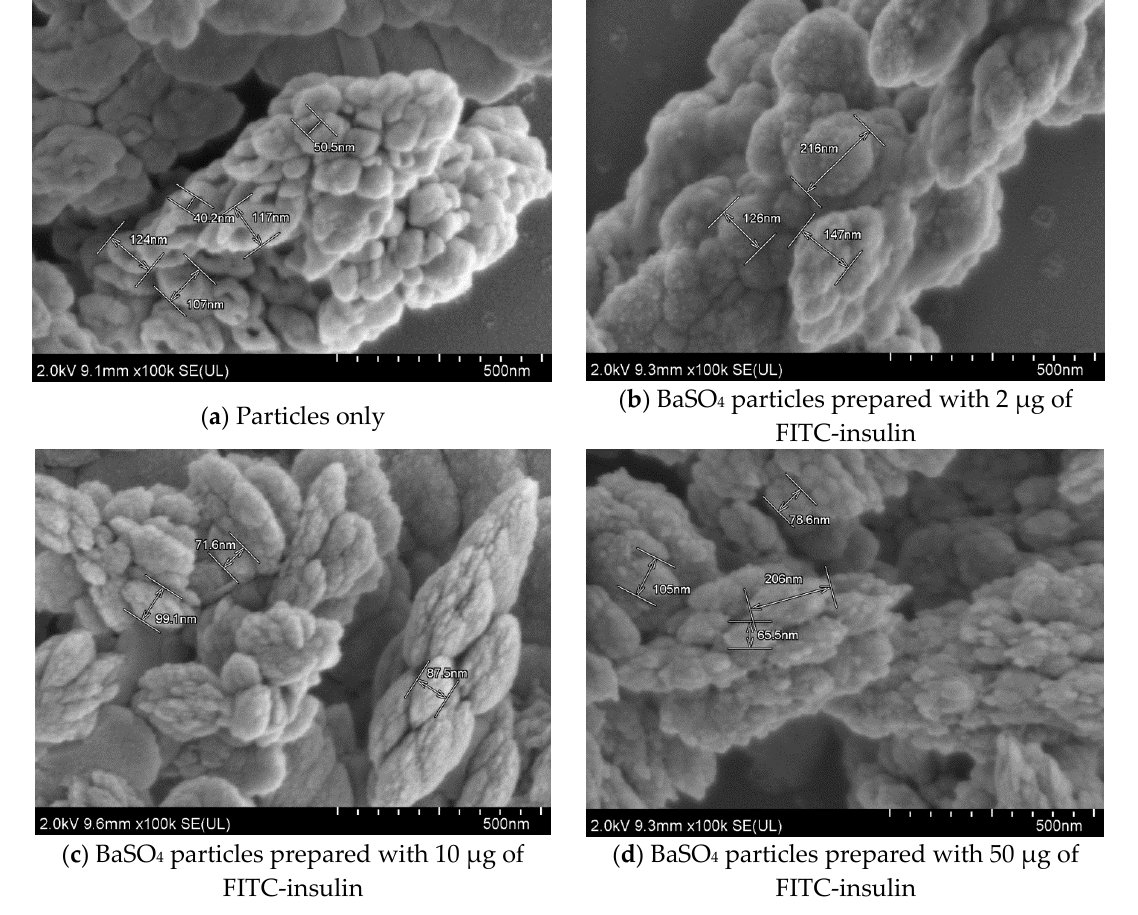
Figure 8. FE-SEM images of BaSO 4 particles (free and loaded with insulin).